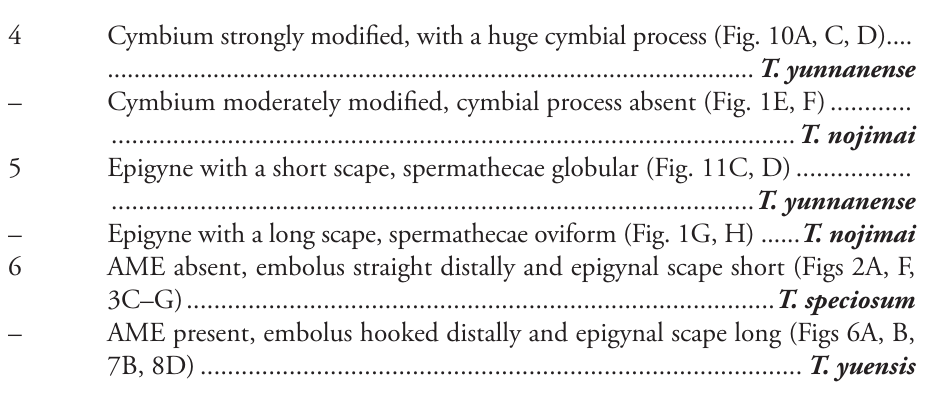
Figure 1 (as modified from Ono,